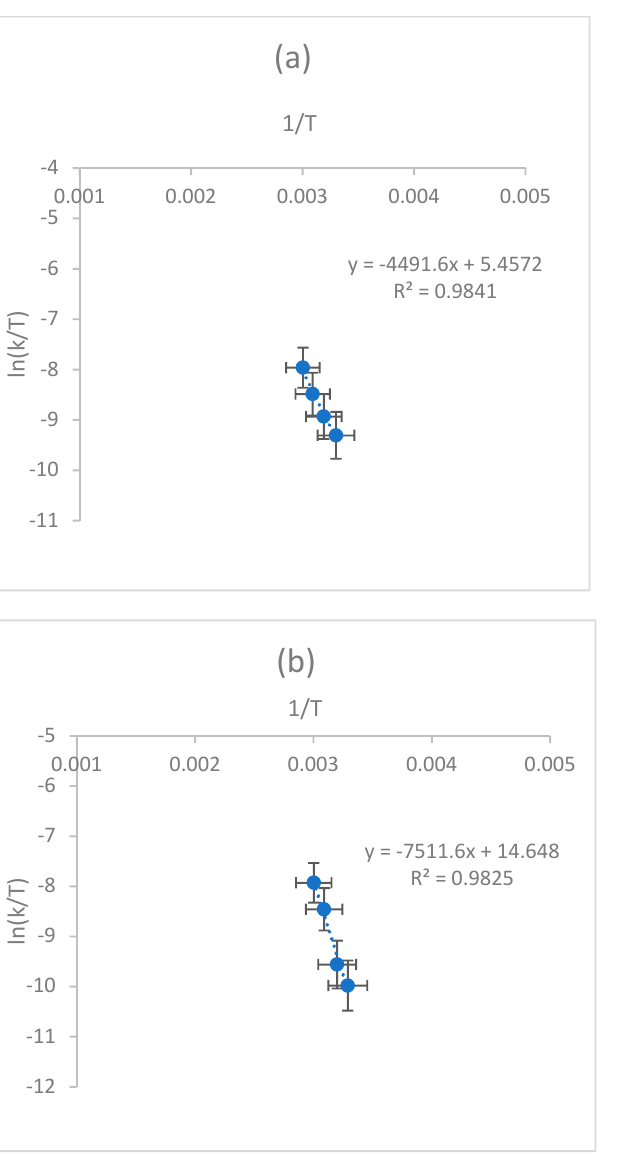
Figure 9. The graph of 1/ T versus ln(k/T). ( a ) DMAB graph and ( b ) LiBH 4 graph. The Eyring equation is given in Equation (4). 1/ T versus In( k / T ) was plotted and the activation enthalpy ( ∆ H # ) and activation entropy ( ∆ S # ) were calculated (Figure 7) [40]. In Equation (4), T is the temperature in Kelvin, R is the gas constant (8.314 J mol − 1 K − 1 ), k is the rate, h is the Planck constant (6.63 × 10 − 34 J · s), k B is the Boltzmann constant (1.38 × 10 − 23 J · K − 1 ), ∆ S # is the activation entropy is, and ∆ H # is the activation enthalpy. For DMAB, ∆ S # is − 152 J mol − 1 K − 1 and ∆ H # is 37.34 kJ mol − 1 . For LiBH 4 , ∆ S # is − 75.74 J mol − 1 K − 1 and ∆ H # is 62.45 kJ mol − 1 . Negative activation entropies are considered to show that the total number of molecules decreases in the hydrolysis rate-determining step of the elementary reaction and that the reaction proceeds through an associative mechanism that may include the participation of the water molecule on the reactant substrate in the rate-determining step [34].